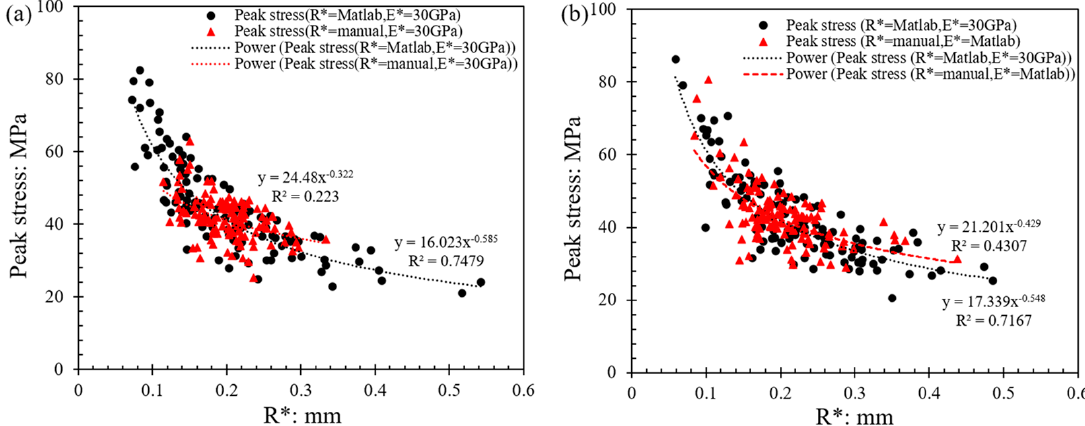
Figure 5. Effect of particle equivalent radius on peak stress at a loading rate of ( a ) 0.01 mm/min; ( b ) 1 mm/min.